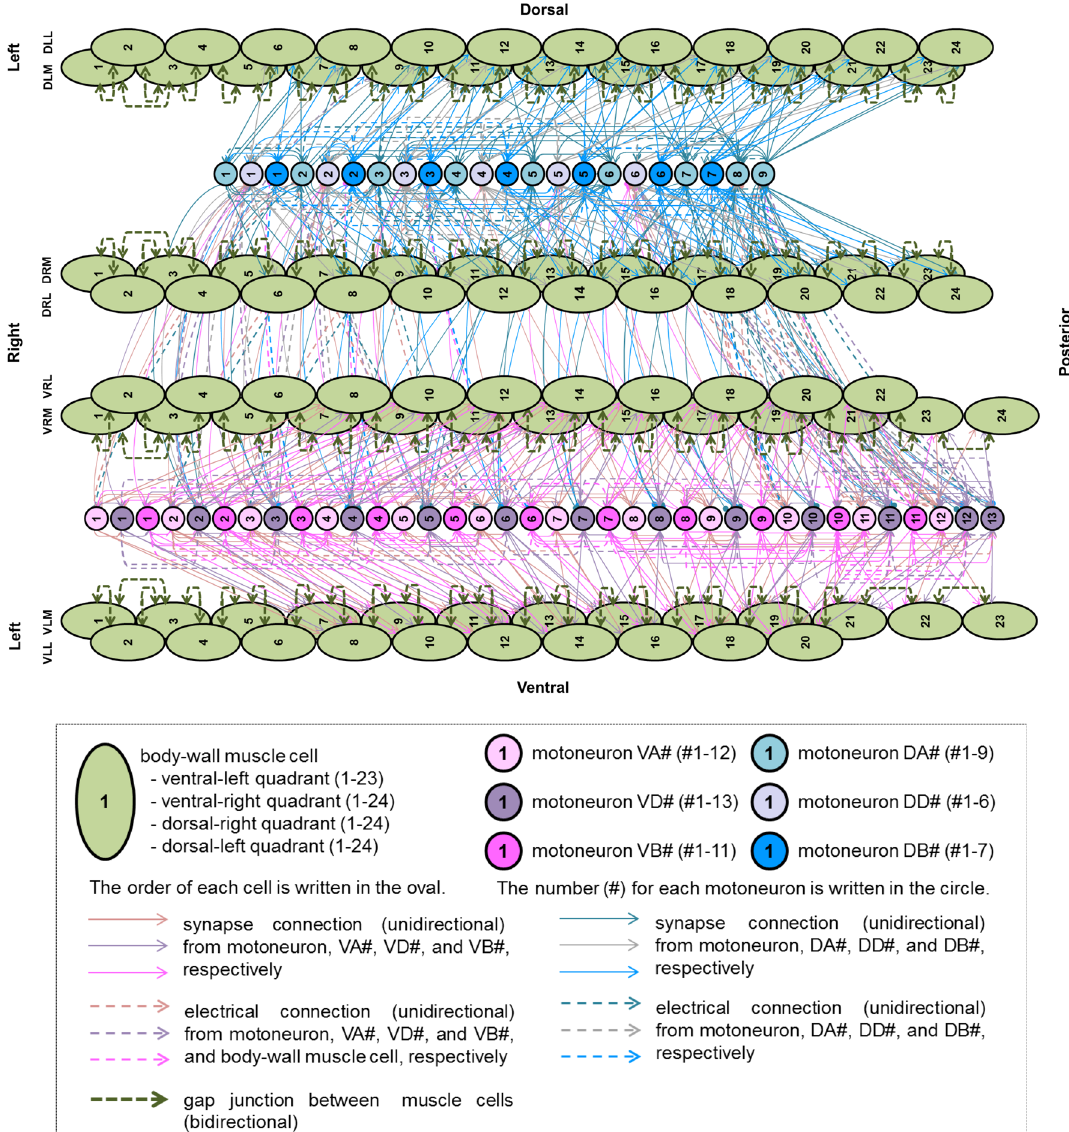
Figure 1. Diagram of neuro-muscular connections illustrated based on the WormAtlas database 6 . Synaptic connections and gap junctions of whole muscle cells (total 95) and motor neurons VA, VD, VB, DA, DD, and DB. The green oval represents the body-wall muscles, the left side of the figure is the anterior direction, the right side is the posterior direction, and, starting from the upper row, it shows the left dorsal side, right dorsal side, right ventral side, and left ventral side. The circles represent motor neurons, and the difference in color corresponds to the types of motor neurons, as shown in the legend. Solid lines represent synaptic connections, and dotted lines represent gap